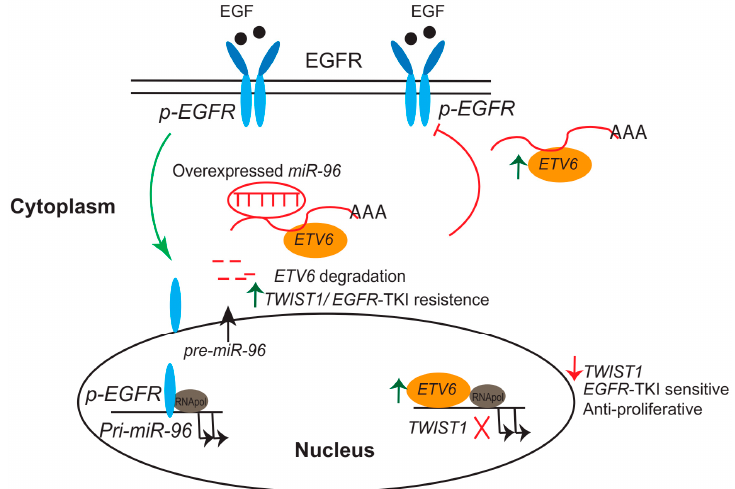
Figure 2. Proposed model for TWIST1 / epidermal growth factor receptor tyrosine kinase inhibitor (EGFR-TKI) resistance and tumor progression. Degradation of ETV6 through activation of EGFR signaling-mediated overexpression of miR-96 contributes to tumor progression and activates drug resistance as a result of TWIST1 expression ( Left ). Overexpression of ETV6 inhibits EGFR activation and acts as a transcriptional repressor for TWIST1 ( Right ) .